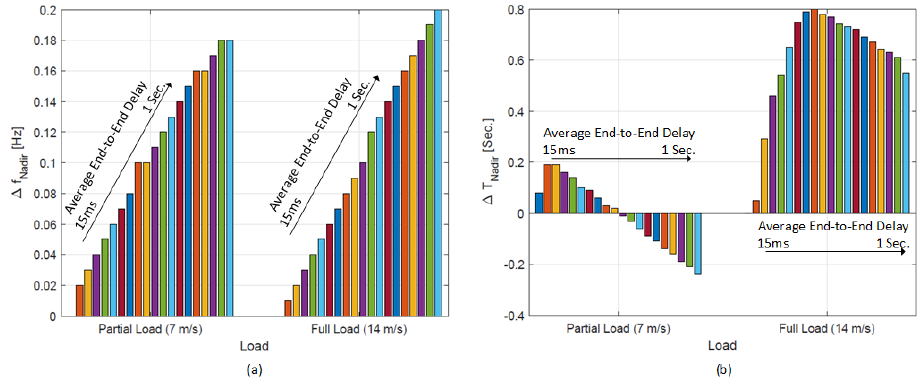
Figure A2. For Test Scenario 3, figure showing a trend in ( a ) f Nadir and ( b ) T Nadir in comparison with that of reference frequency response under a sequence of increasing end-to-end network